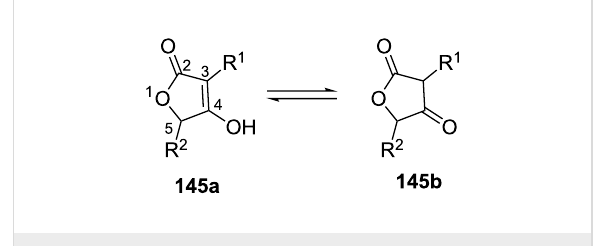
Figure 5: Mesomeric structures of tetronates [138,139].